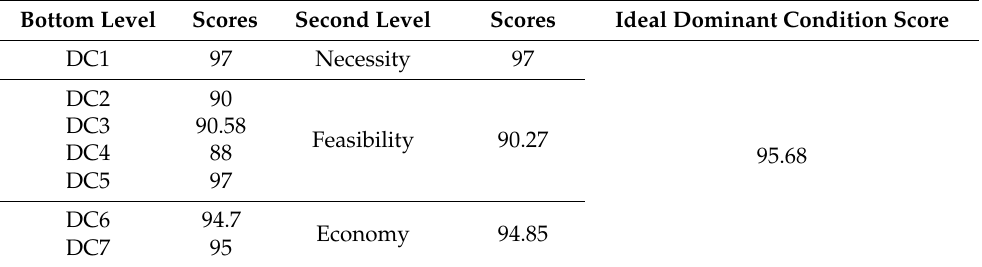
Table 8. The ideal dominant condition score of project 1. Bottom